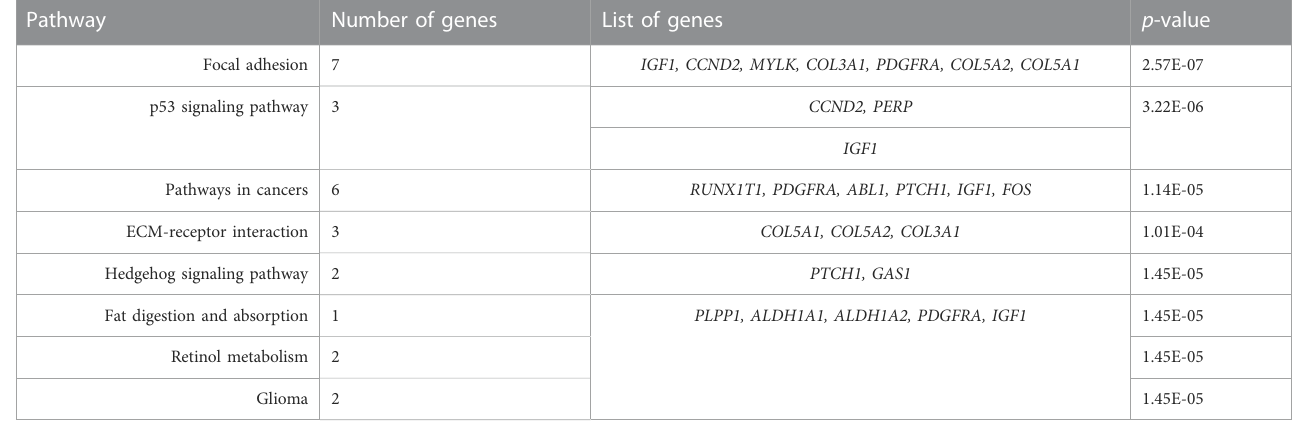
TABLE 3 The functional enrichment of downregulated genes in KEGG pathways.